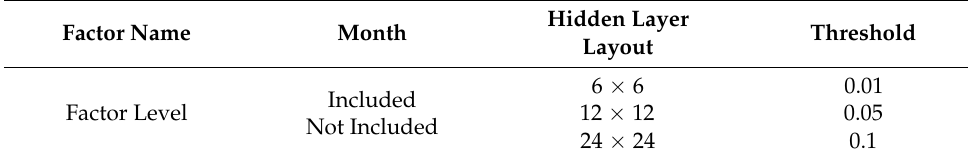
Table 2. Levels of factorial design for artificial neural network model